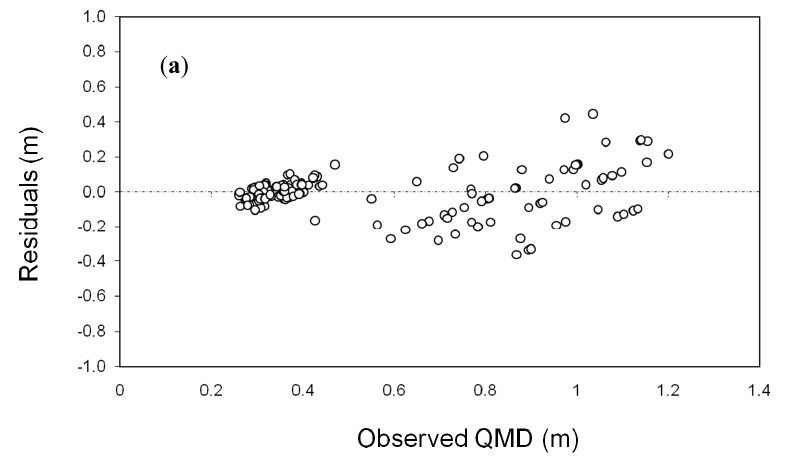
Figure 5. Plot of the observed QMD, BA, and N versus the residuals of the